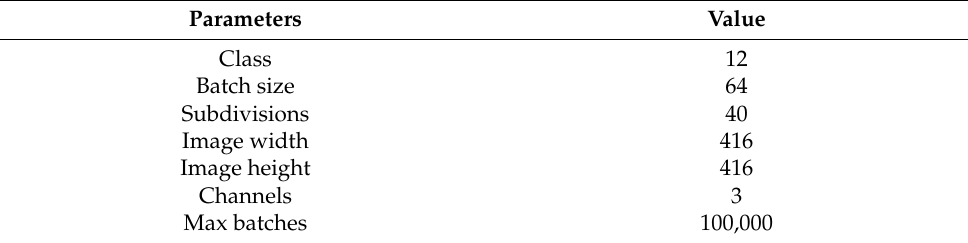
Table 10. Experimental setup for training